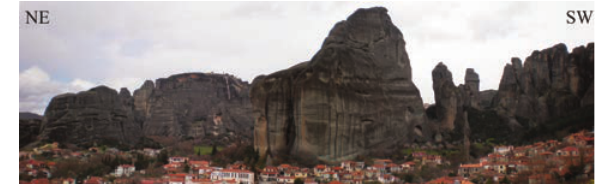
Figure 2. An aspect of the geomorphological features developed on the molassic strata is shown. The visible discontinuities of tec- tonic origin are crossing the stratigraphic bedding and allow the groundwater flow through selective